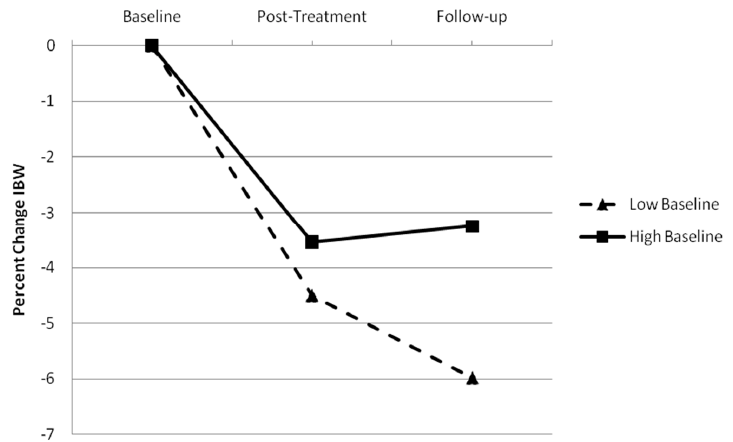
Figure 2. Using the Intention-to-Treat analysis, figure represents the percent change in initial body weight at post-treatment and follow-up for participants reporting low baseline Weight Bias Internalization Scale scores and those reporting high baseline Weight Bias Internalization Scale scores.